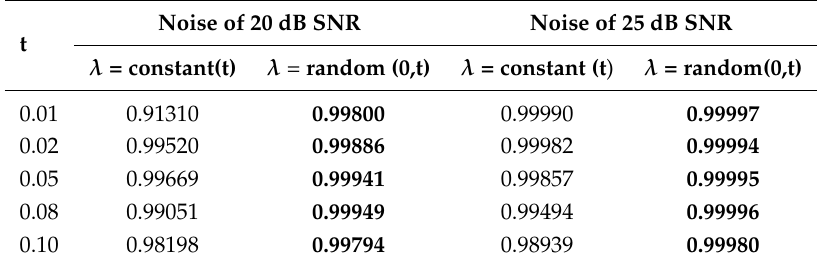
Table 4. The area under the ROC curve of E-CEM with different regularization coefficient λ on synthetic data under the interference of white Gaussian